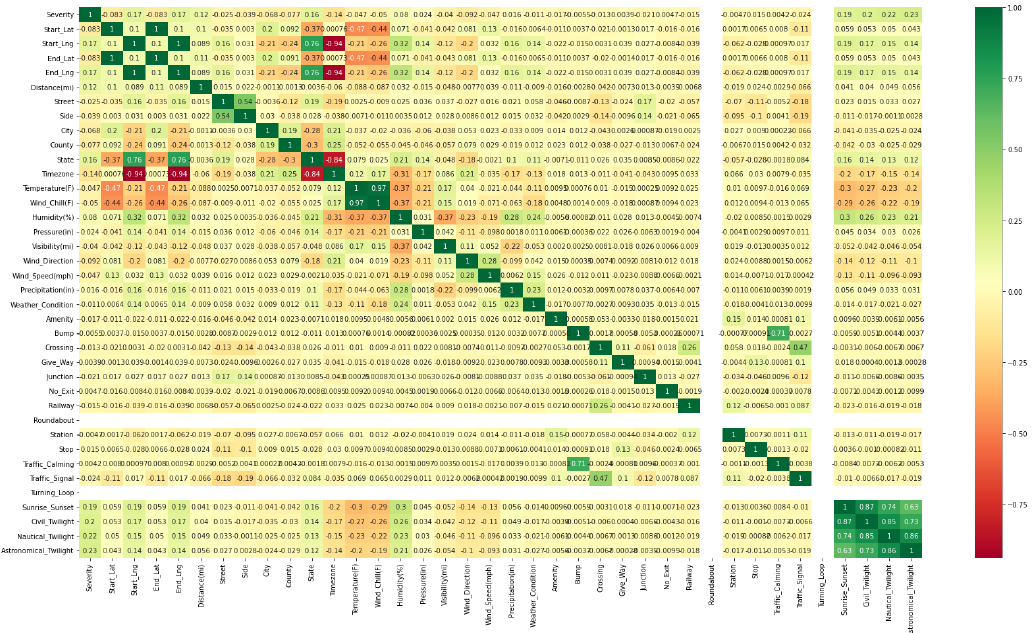
Figure 2. Correlation heatmap with independent and MEDV output variables.